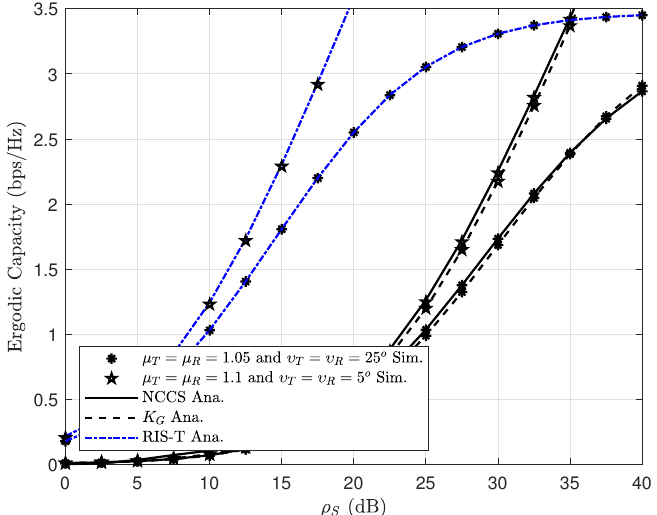
Figure 10. The outage probability vs. ρ S (dB) with varying µ T = µ R and υ T = υ R with N =